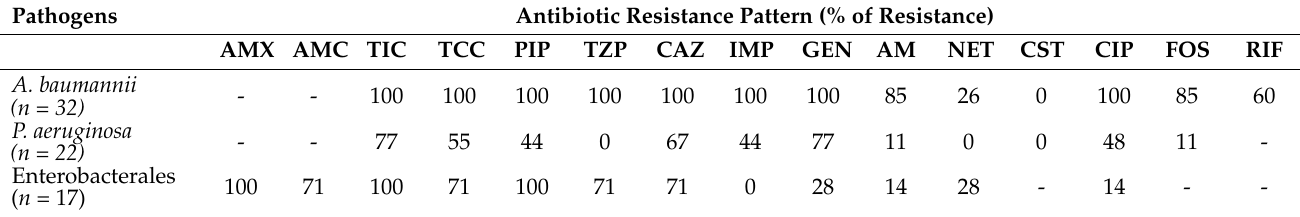
Table 4. Etiological agents of VAP and antibacterial resistance pattern. Pathogens